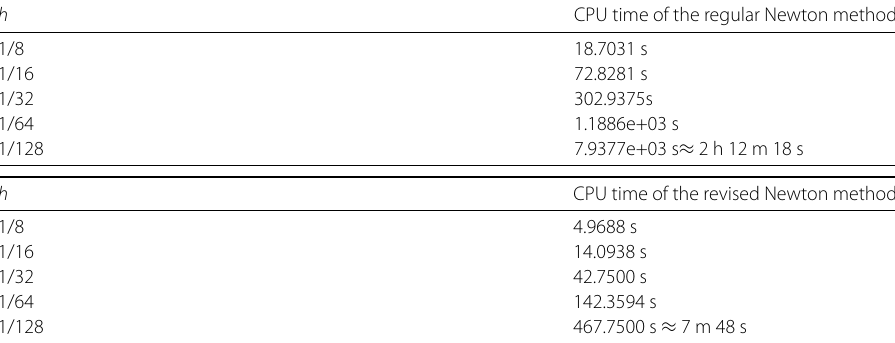
Table 7 The consumed CPU time of the regular Newton method and the revised Newton method h CPU time of the regular Newton